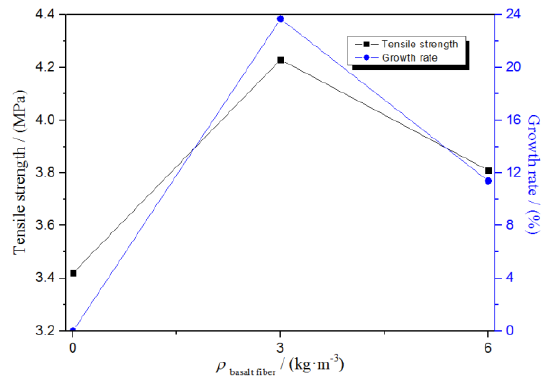
Figure 12. Tensile strength and its increasing